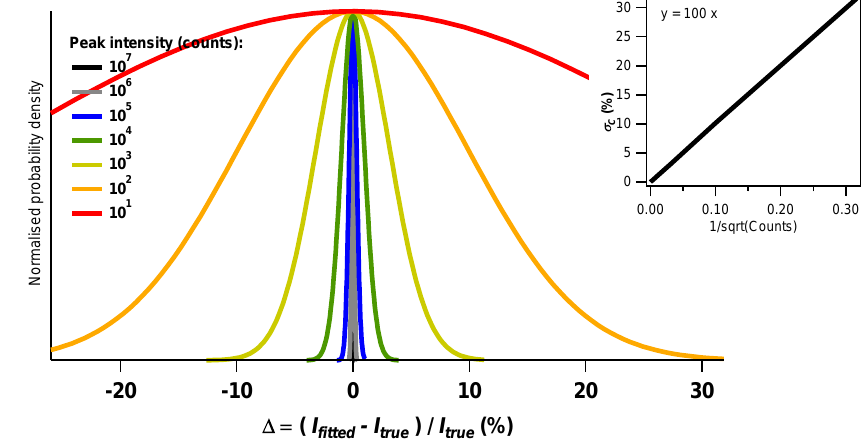
Figure 1. Histograms of the normalised deviation in fitted peak intensity, (cid:49) , for 10000 simulations of peak fitting to an isolated Gaussian ion peak degraded with counting error and centred at 2000ns, data-point spacing 0.2ns and peak width 1ns. Shown inset, the linear relationship between the histogram width σ C , given as the standard deviation in (cid:49) and the fitted peak intensity.